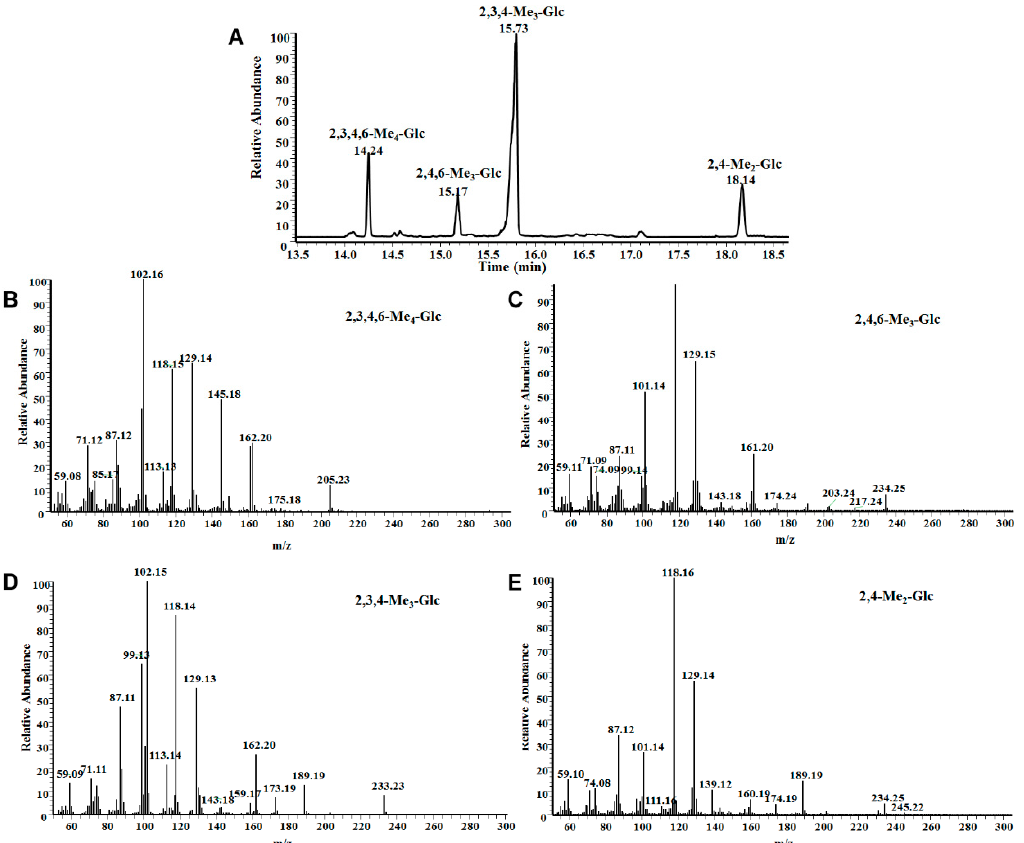
Figure 2. The GC-MS data of the partially methylated alditol acetates of LeP-N2. ( A ) GC-MS elution spectra of LeP-N2 after methylation. ( B ) Mass spectrometry fragments of Glc p -(1 → . ( C ) Mass spectrometry fragments of → 3)-Glc p -(1 → . ( D ) Mass spectrometry fragments of → 6)-Glc p -(1 → . ( E ) Mass spectrometry fragments of → 3, 6)-Glc p -(1 → .